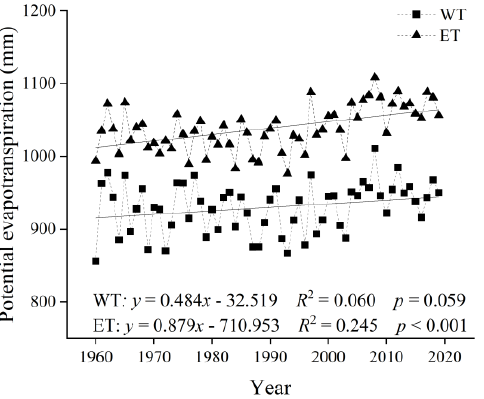
Figure 9. Variability of the annual potential evapotranspiration during 1960 – 2019.